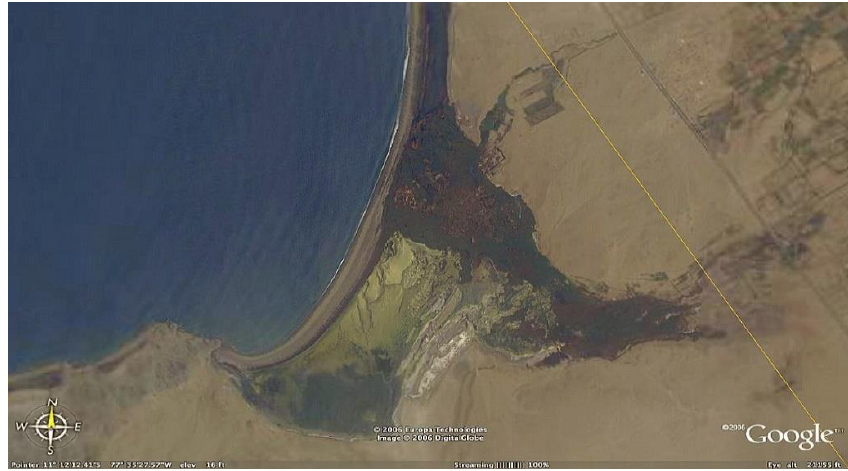
Figure 32. Extensive beach ridge formation in the Supe Valley coastline area. Existing segment of the Medio Mundo beach ridge shown. Result from Google Earth.